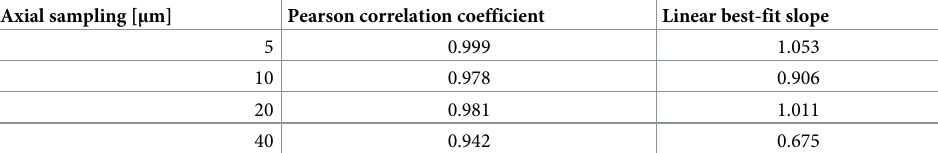
Table 5. Algorithm performance compared to mean of expert manual counts with varying axial sampling. Axial sampling [ μ